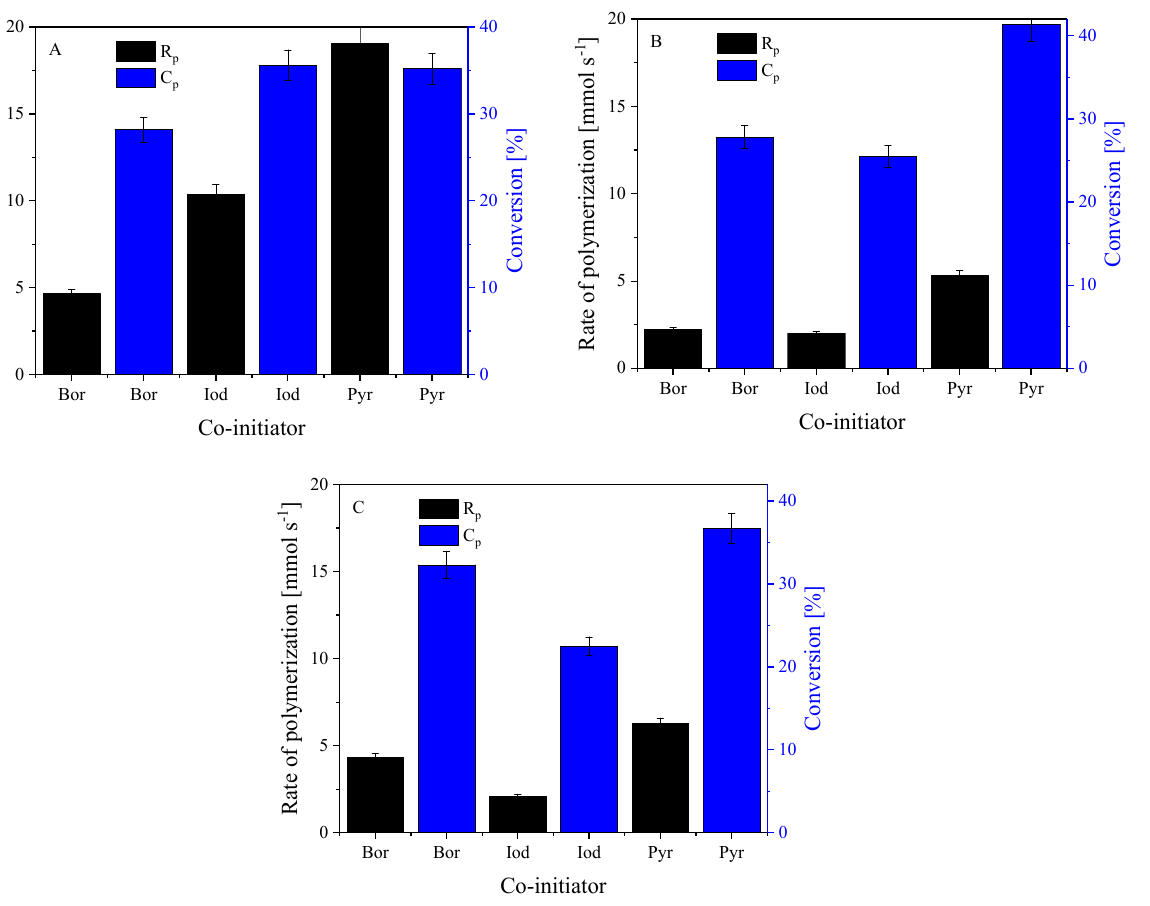
Figure 5. Polymerization of TMPTA in the presence of BODIPY dyes ( A ) (1) 4-N(CH 3 ) 2 , ( B ) (5) H, ( C ) (7) 4-Cl, under irradiation with UV-Vis light. Light intensity: 50 mW cm − 2 .